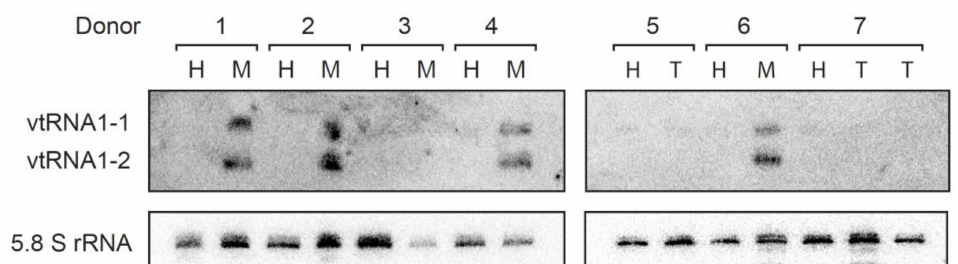
Figure 2. Vault RNAs are abundantly expressed in liver samples. Northern blot analysis in paired patient-derived tissues was performed as described in [53] and revealed that vtRNA1-1 and vtRNA1-2 are expressed in metastatic but not in non-pathological adjacent liver tissues; healthy (H), tumor (T) and metastasis (M). 5.8S rRNA serves as internal loading